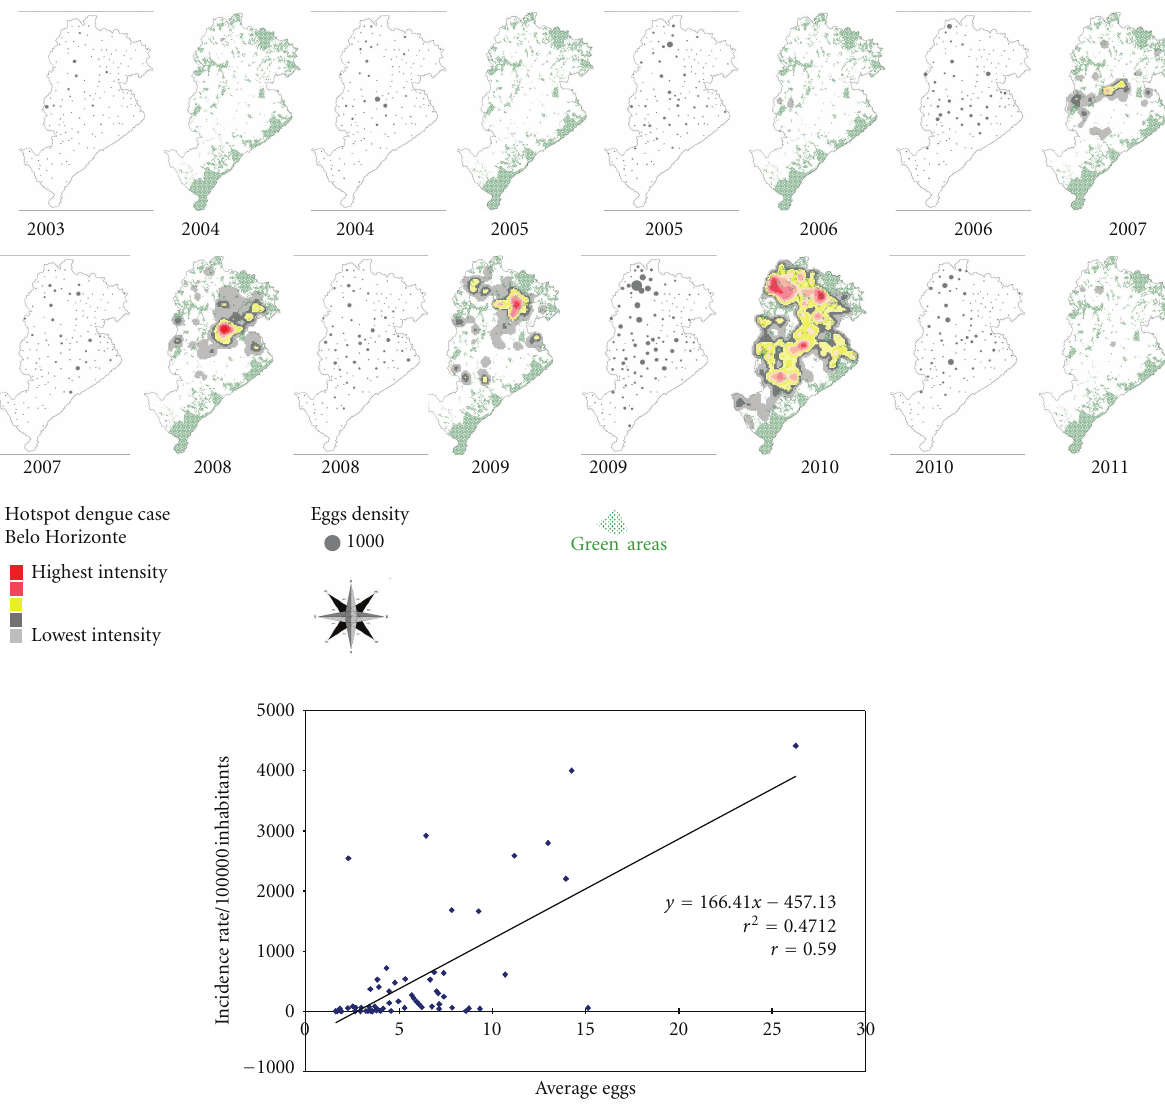
Figure 6: Aedes aegypti eggs in ovitraps, September-October survey, and dengue outbreaks, temporal dynamics in space, 2003–2011, and linear regression graphic (incidence versus mean number of eggs), Belo Horizonte, MG,